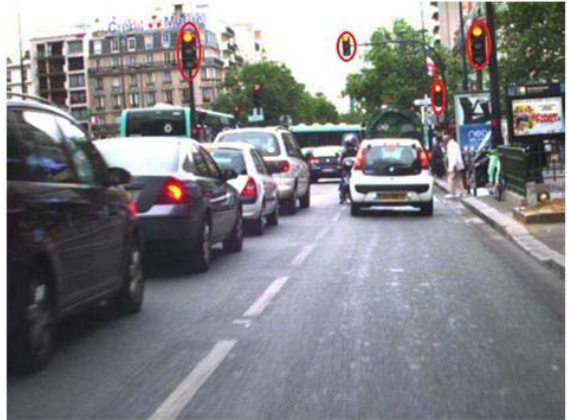
Fig. 1. Source image will be used as reference for further demonstrations. Traffic lights are emphasized only to be more easily visible by the